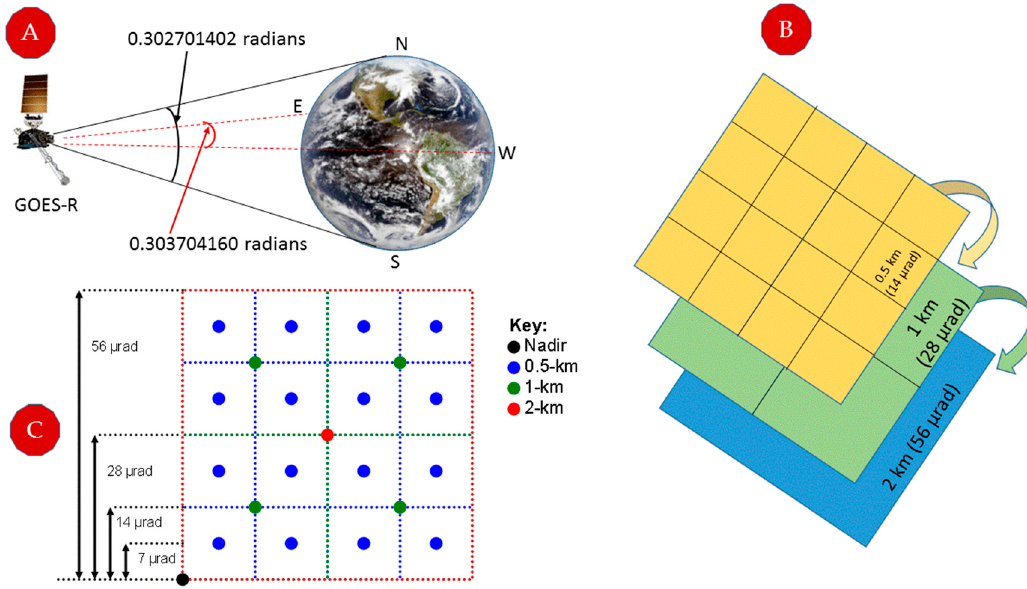
Figure 10. East to West and North to South observation geometry of the Earth about the satellite’s x and y axis, respectively ( A ). The 0.5-km, 1-km, and 2-km spatial resolution map grids are exactly registered to each other ( B , C ).